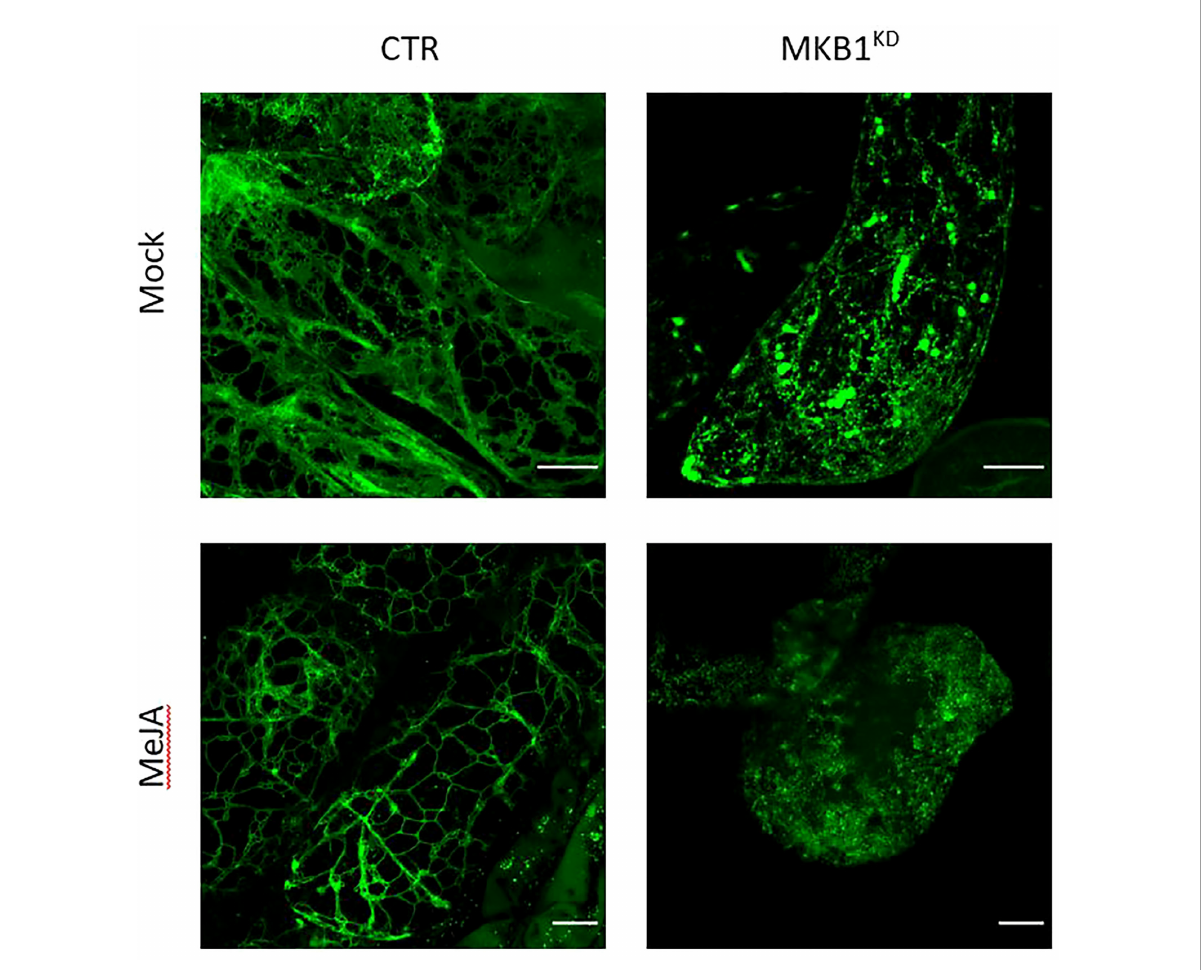
FIGURE 1 Silencing of MKB1 and MeJA elicitation alters the ER network structure. Shown are maximum intensity projections of images obtained by Airyscan microscopy of ER-targeted GFP in stably transformed CTR and MKB1 KD M. truncatula hairy roots. Left, CTR roots elicited (24 h) with ethanol (mock) or 100 µM MeJA. Right, mock- and MeJA-treated MKB1 KD roots. Scale bars = 20 m